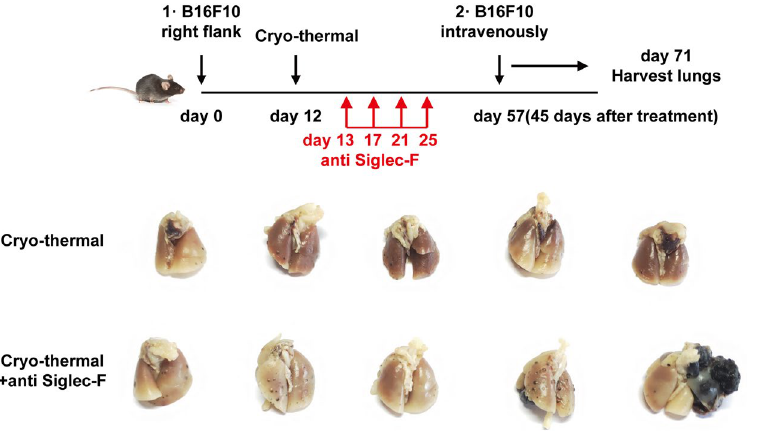
Figure 8. Cryo-thermal-activated eosinophils protected mice from pulmonary metastatic B16F10 tumors. Photographic images of lungs from cryo-thermal treated and cryo-thermal therapy with eosinophils depleted B16F10 tumor-bearing mice, respectively. Upper: schematic of experimental design. Lower: photographic images of